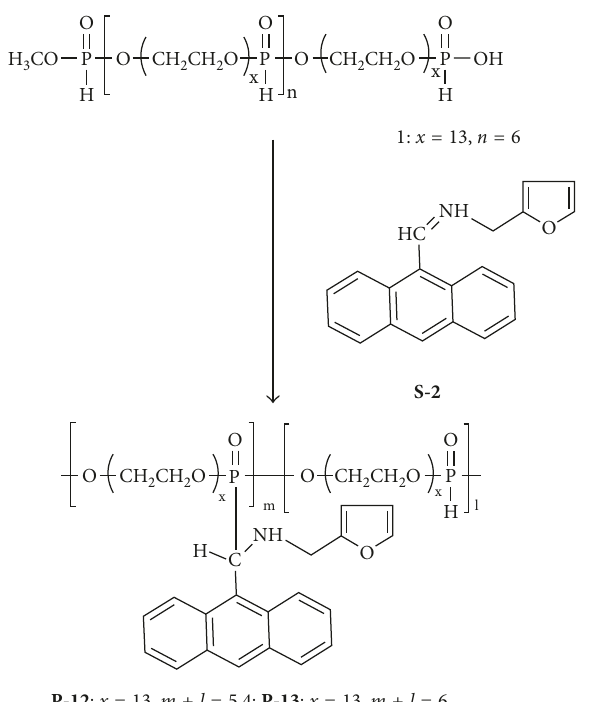
Scheme 1: Synthesis of poly[oxyethylene(aminophosphonate-co- H-phosphonate)]s P-12 and P-13